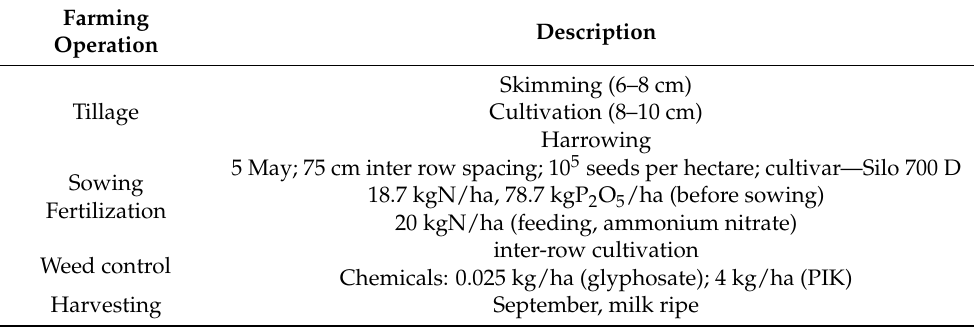
Table 1. Production of sweet sorghum.